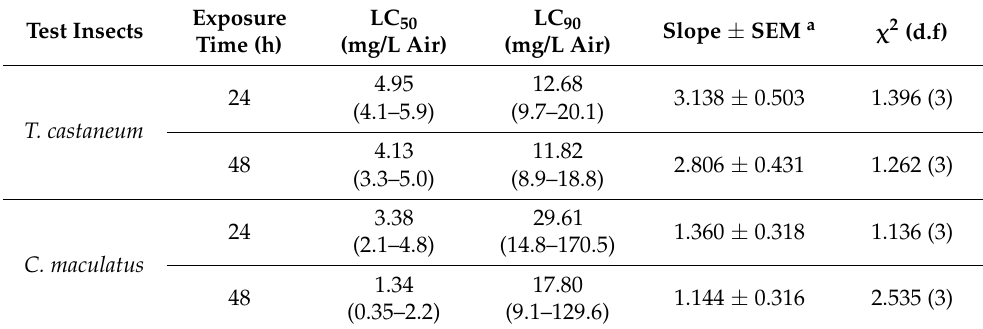
Table 3. Lethality of CMEO by fumigation against T. castaneum and C. maculatus . Test